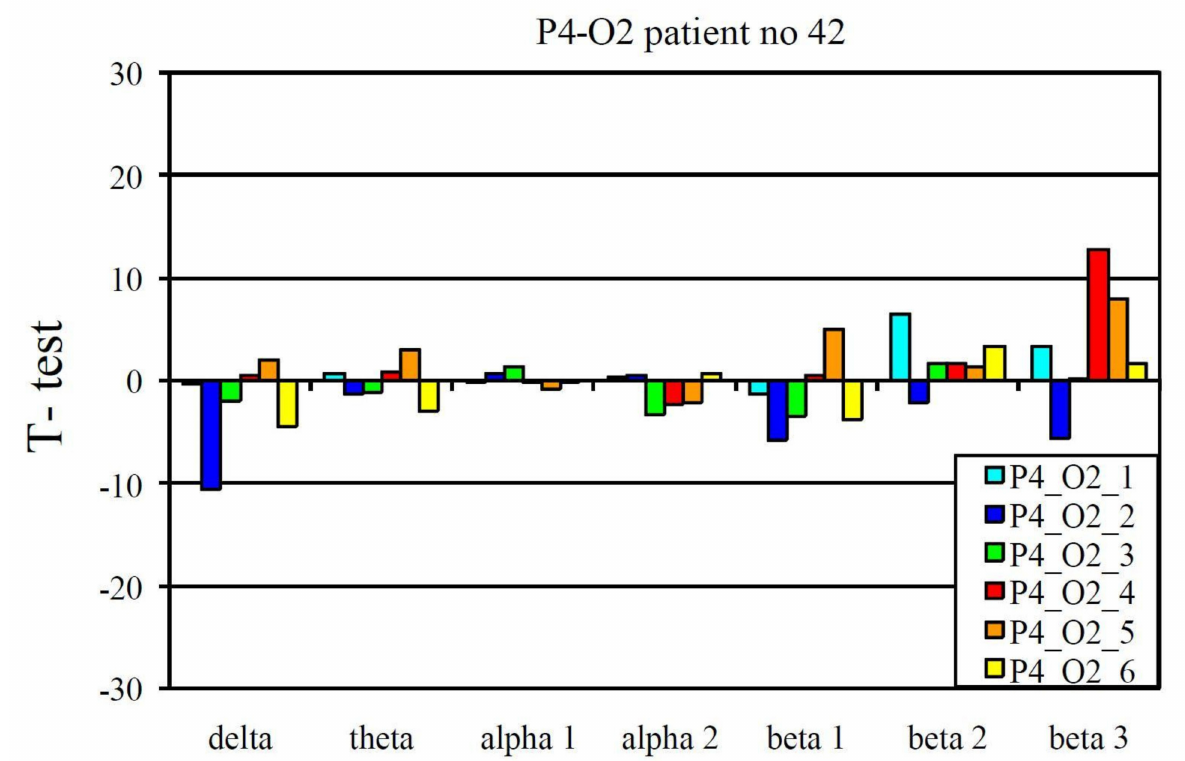
Figure 1. A positive pharmaco-EEG profile observed during tricyclic antidepressant